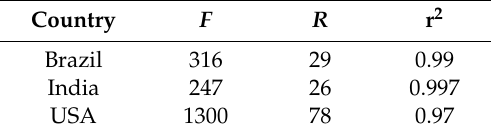
Table 4. Values for coefficients A and B for Brazil, India, and USA.